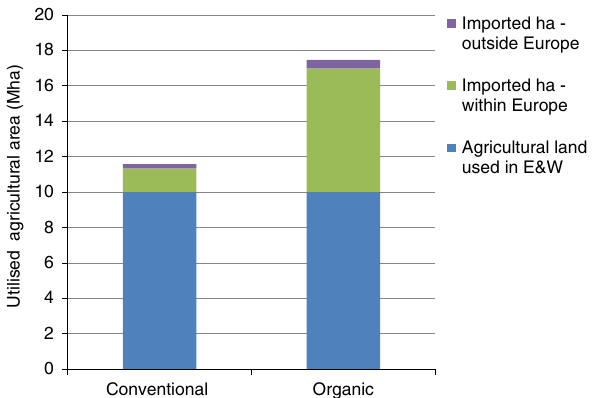
Fig. 4 Overseas land area needed for imported food. The area required to offset shortfalls in domestic production under organic methods is over fi ve times that under conventional methods, largely due to imports of oilseeds, pork, poultry meat, eggs and milk. Note only the products listed in Fig. 1 are included; products that are not produced in the UK on a large scale (such as maize, rice, tea, coffee and sugar cane) are excluded (Methods). Source